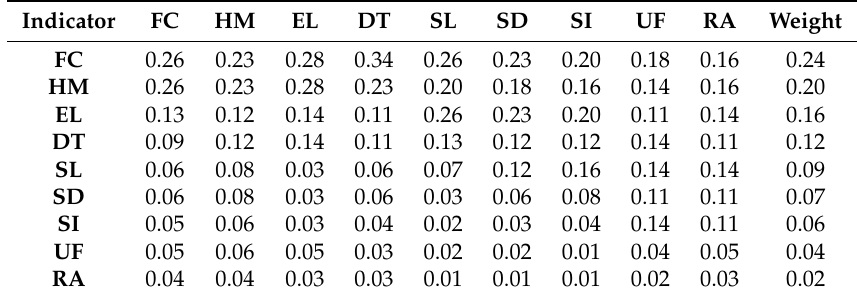
Table 3. Comparison matrix and weighted value of indicators based on the analytical hierarchy process (AHP) method.